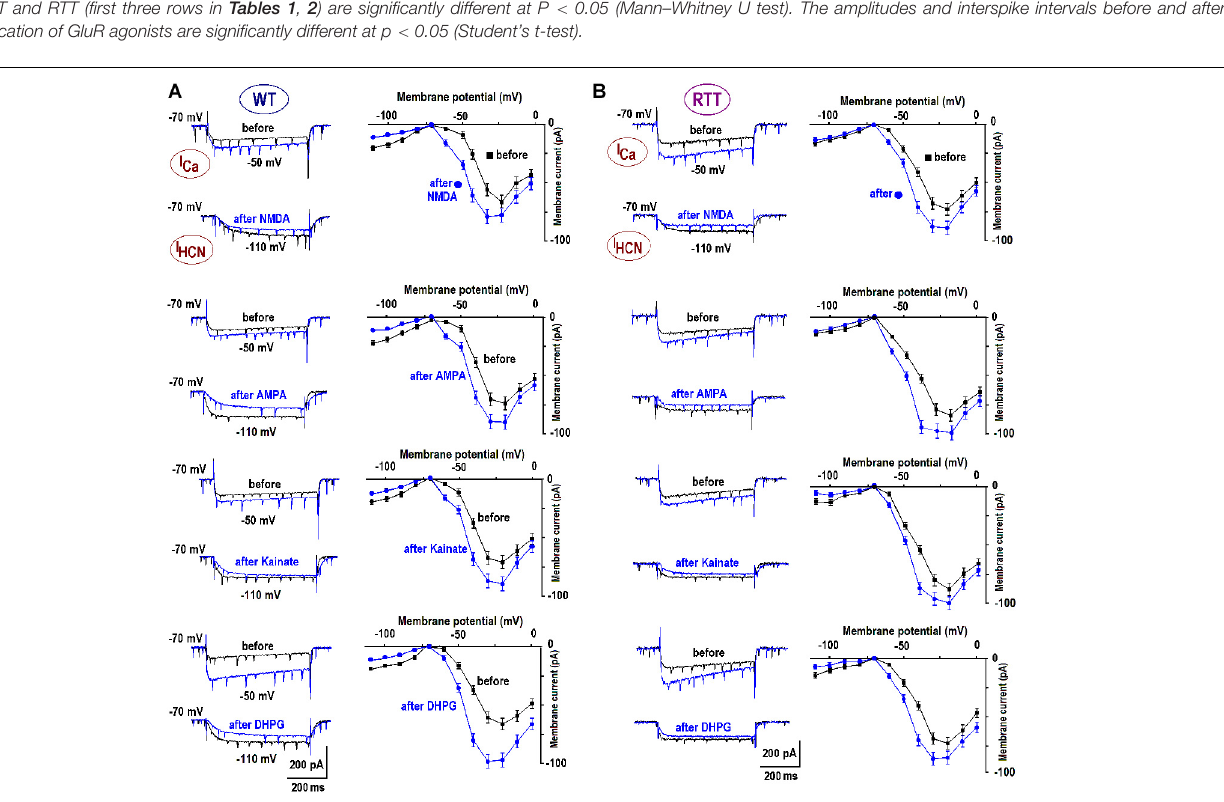
FIGURE 3 | Enhancement of calcium currents and depression of HCN currents after GluR agonists. The data were obtained in CA1 cells from WT (A) and RTT (B) as indicated. Superimposed sample traces present currents evoked by voltage steps from –70 to –50 mV to evoke subthreshold calcium current, and to –110 to maximally activate HCN current, respectively. The traces were measured before and 10 min after the application of GluR agonists (10 µ M NMDA; 10 µ M AMPA; 1 µ M kainate; and 1 µ M DPHG). The graphs show mean I–V curves obtained in these experiments. Calibrations are the same in all panels and scale bars are indicated below the last pair of